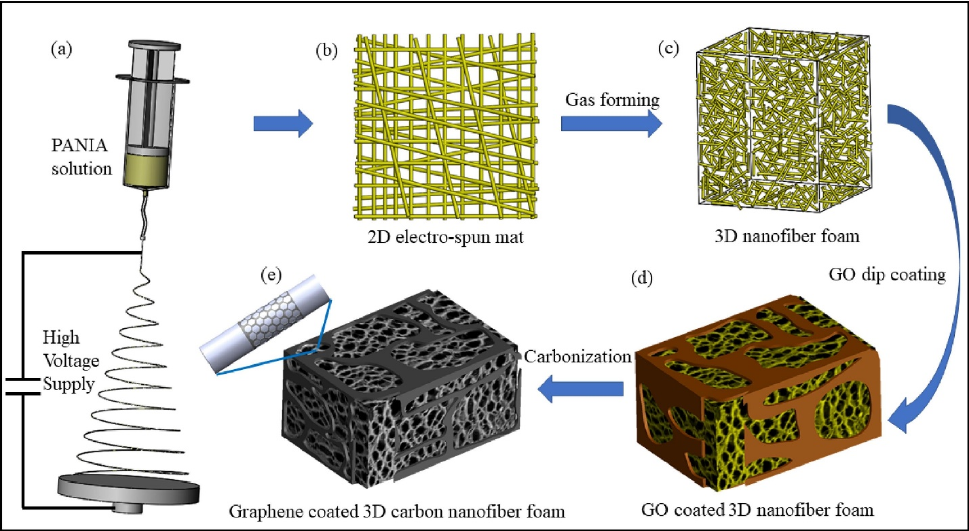
Figure 3. Illustration of gas foaming method for aerogel composite preparation: ( a ) electrospinning set-up, ( b ) 2D nanofiber mat, ( c ) 3D nanofiber foam, ( d ) graphene oxide coated 3D fiber foam, ( e ) carbonized aerogel composite. Reproduced with permission from [41], ©2021 Elsevier B.V.